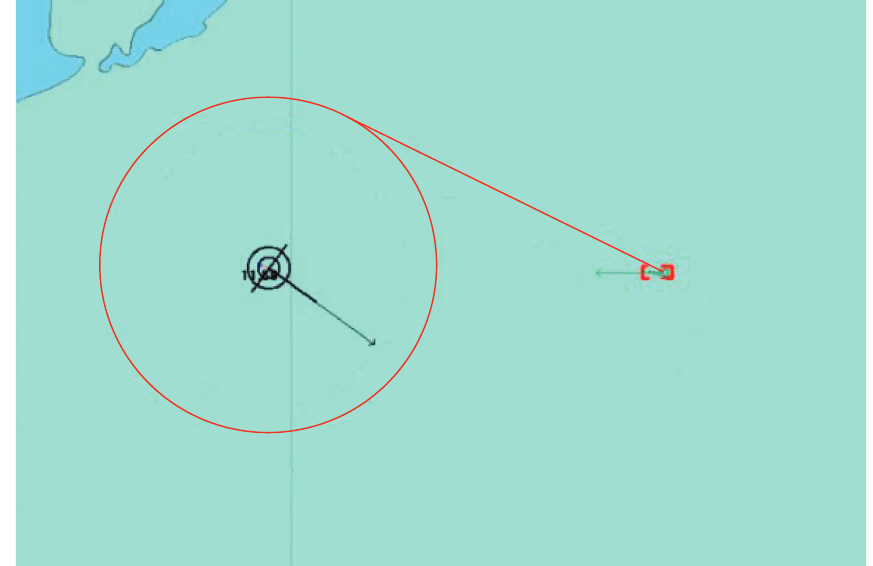
Figure 25: Right-steering collision